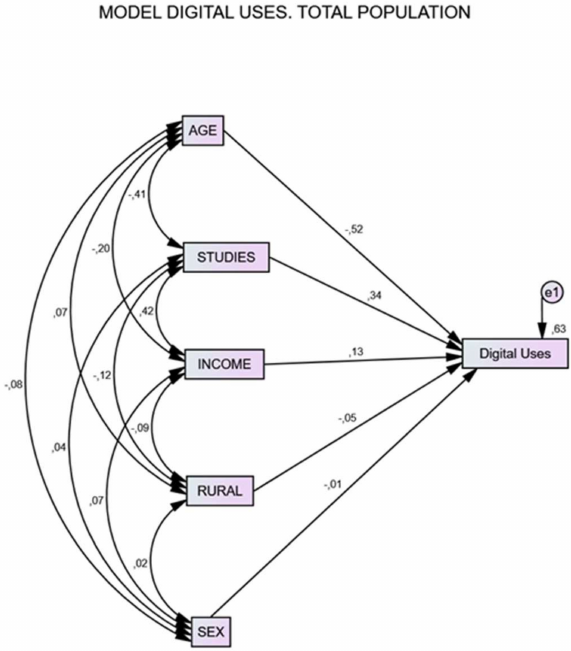
Figure 1. Digital Uses Total Population